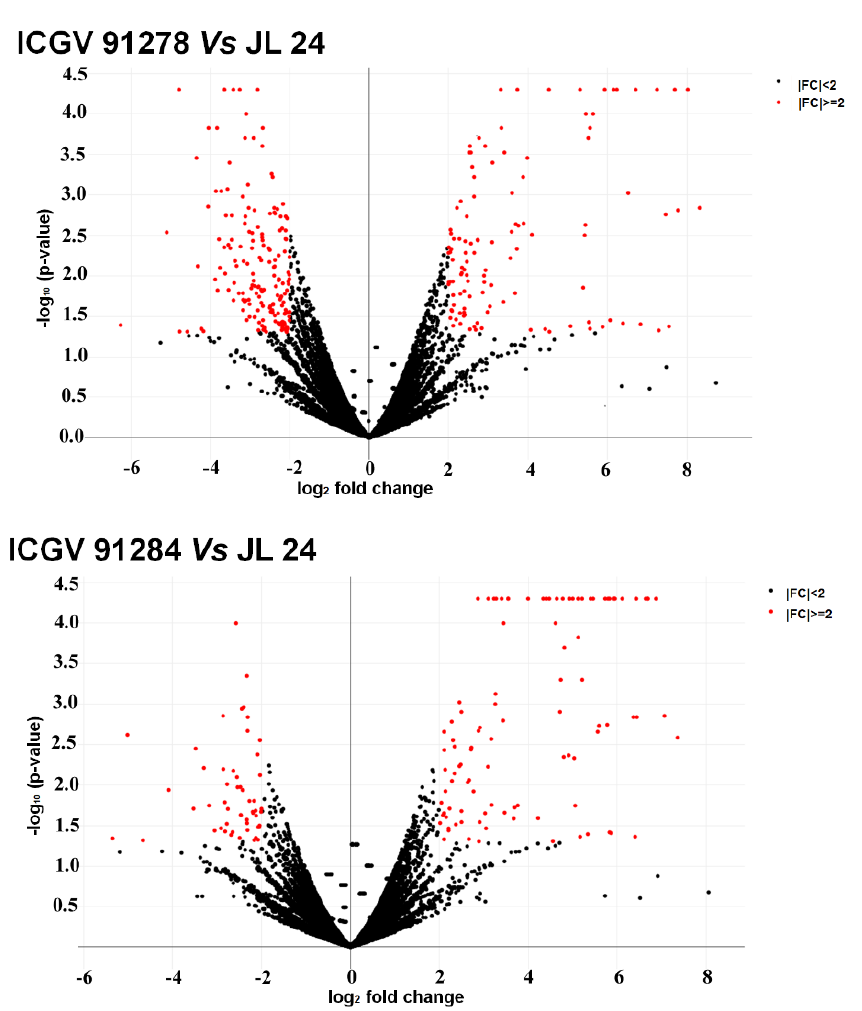
Figure 4. Volcano plot demonstrating the genes that were differentially expressed between susceptible (JL 24) and resistant genotypes (ICGV 91278, ICGV 91284) under infection conditions. Investigation and representation of DEGs were performed for developing Volcano plot. This plot is between log 2 (fold change) and –log 10 of the p-value on the x-axis and y-axis, respectively. Here, each dot is representing a gene and black and red coloured dots represent non-significant and significant genes, respectively.